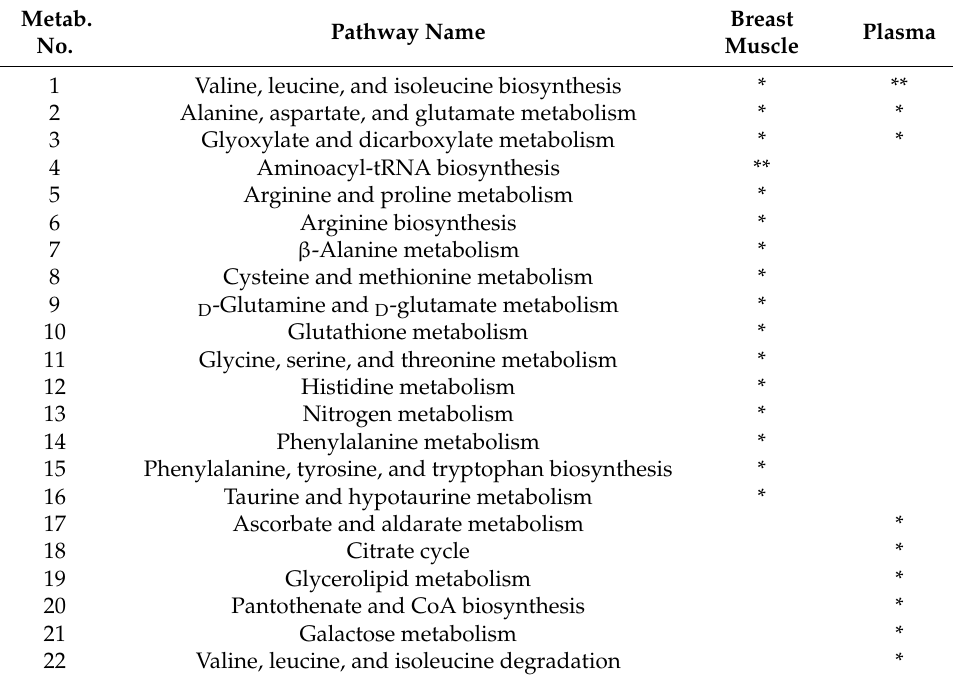
Table 2. Potential metabolic pathways affected by post-hatch development in chickens.